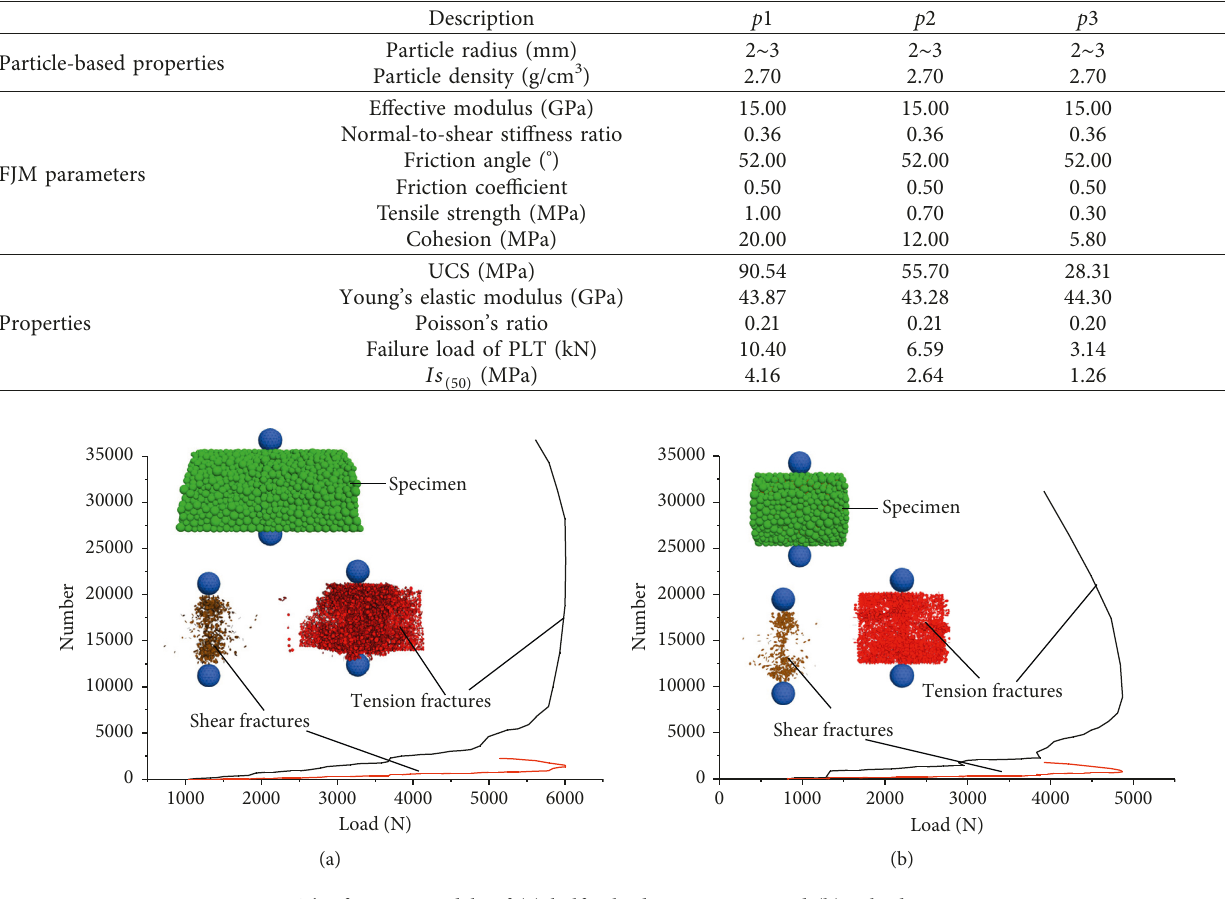
Figure 6: The fracture models of (a) half-cylinder specimens and (b) cylinder specimens.